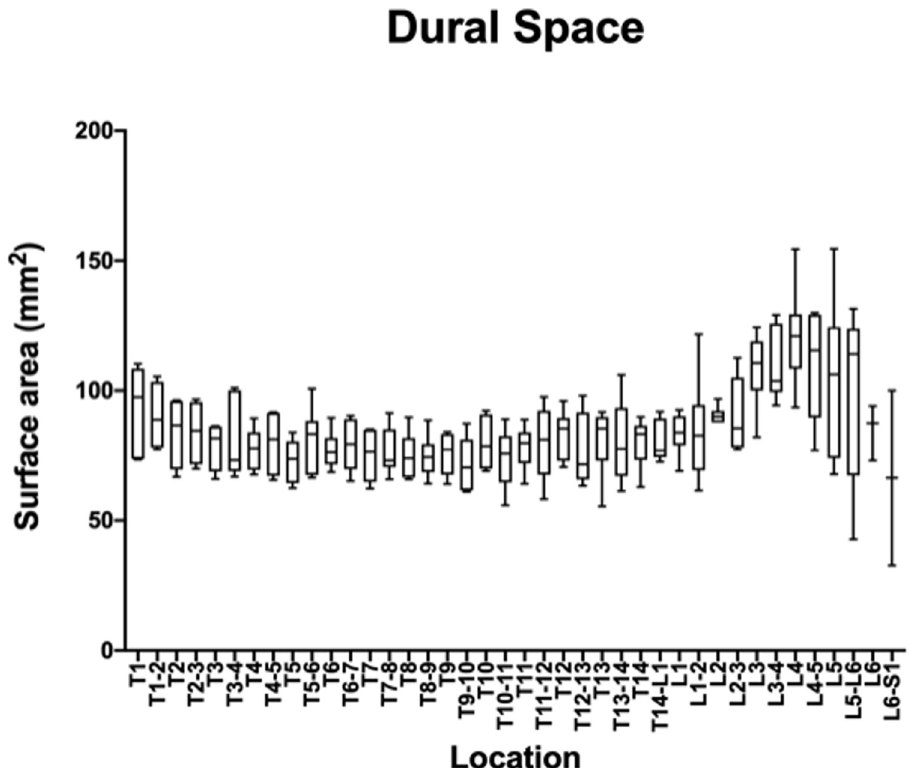
Fig 8. Graph of the dural space surface area (mm2) in 6 Yucatan sows. The median, 75 th , 25 th percentile and the range are shown for each thoracolumbar vertebral